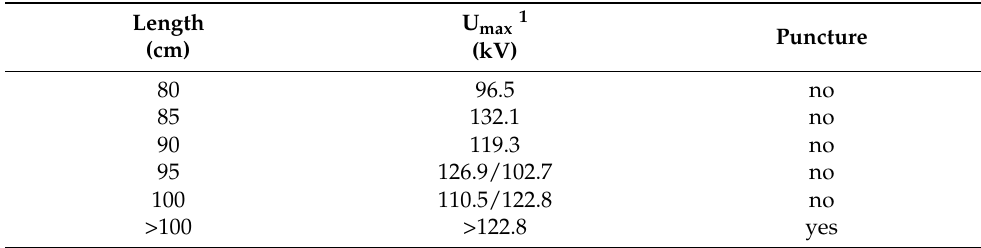
Table 2. Evaluation of the maximum admissible strip length by applying the HV waveform A (1000 kV/ µ s) of negative